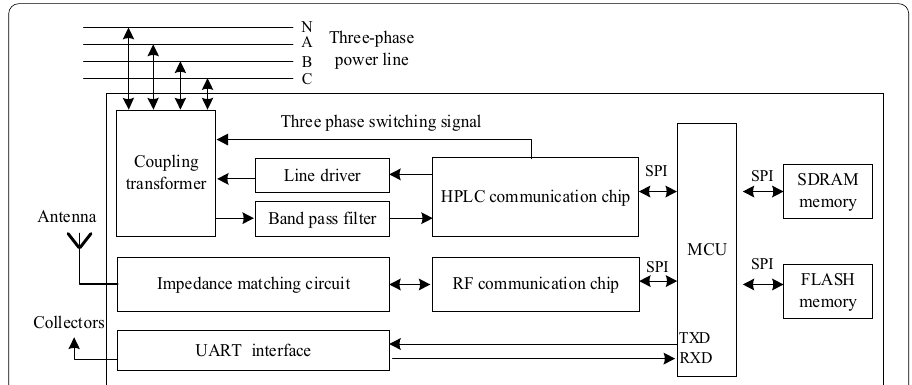
Fig. 2 Hardware composition block diagram of dual-mode communication